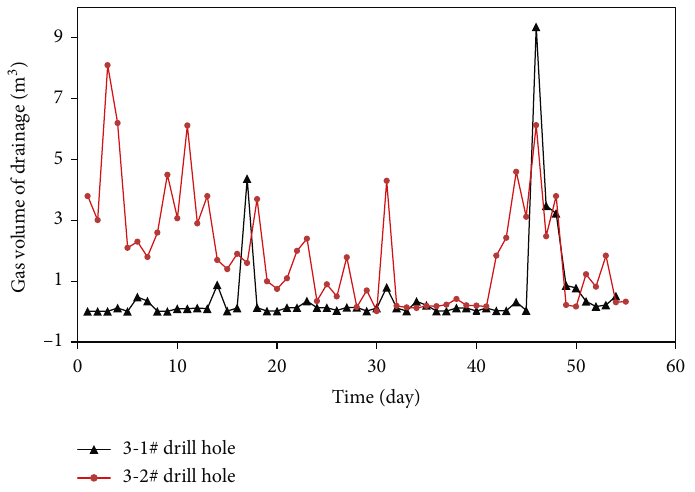
Figure 8: Gas extraction in the borehole group